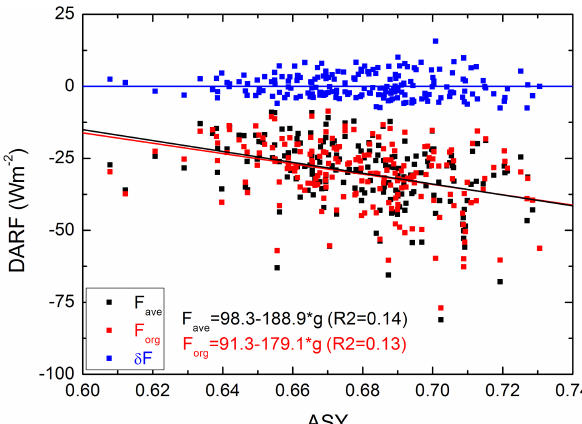
Figure 8. Correlations between aerosol forcing at the surface and AOD at 500nm ( F ave : black; F org : red; δF : blue) with linear fitting equations.